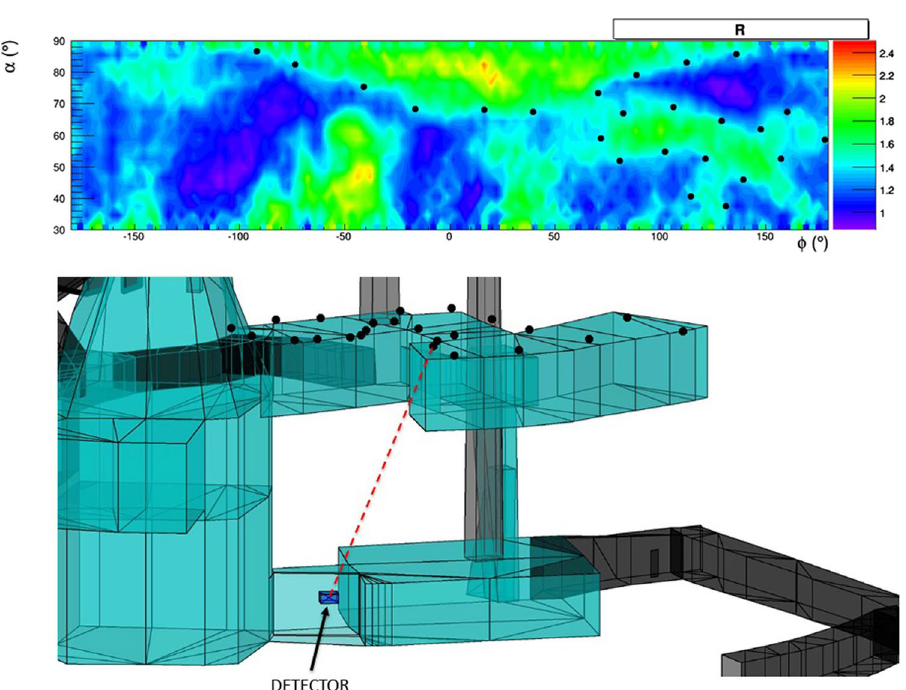
Figure 19. Top: Relative transmission R( ρ θ φ , , ) evaluated with the best estimate of the tuff density ρ = 1.71 g/ cm 3 ; the black dots lie on the contour of one of the structures which are observed. Bottom: Projection of the black dots in the top figure at z = 25 m, corresponding to the ceiling of a known structure. The drawings were obtained using the software root and Autodesk AutoCAD